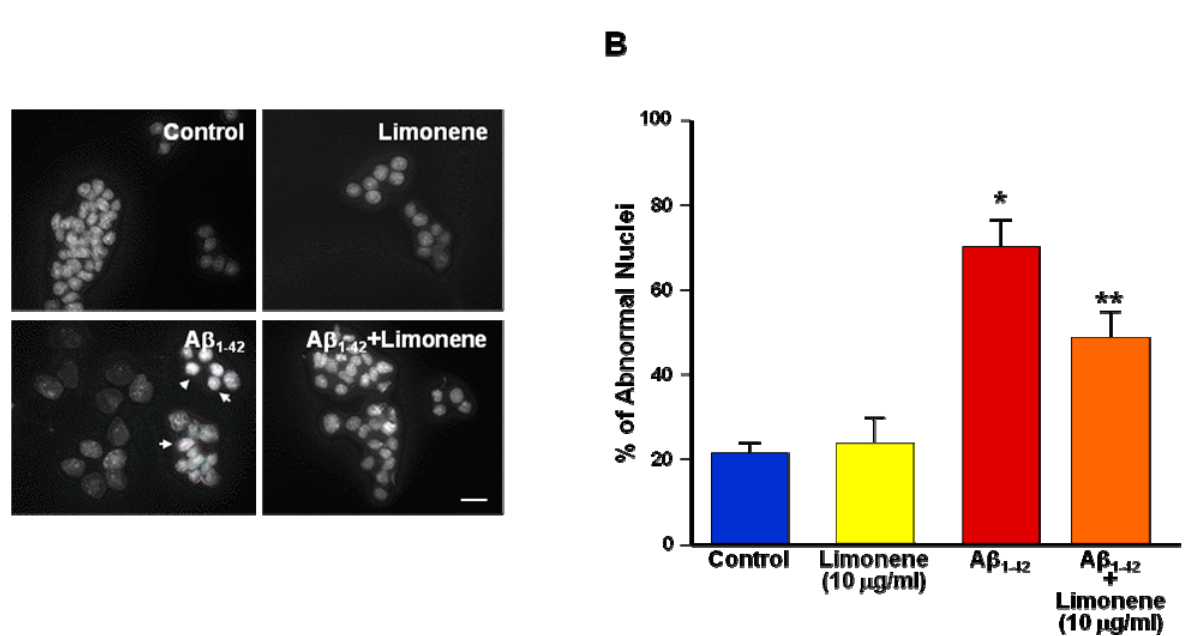
Figure 2. Effects of limonene on nuclear morphology in primary cortical neurons exposed to A β 1-42 oligomers. ( A ) Representative images of Hoechst-33258 nuclear morphological abnormalities in primary cortical neurons under control conditions, in neurons treated with limonene (10 µg/mL/24 h), and treated with A β 1-42 oligomers (5 µM/24 h; see white arrows) in the absence and in presence of limonene (10 µg/mL, 30 min pre-treatment) Scale bar: 20 µm. ( B ) Quantification of nuclear morphology with Hoechst-33258 in A. Data are shown as percentage of abnormal nuclei (relative to total nuclei) and values are expressed as mean ± SEM of four independent experimental sessions in which at least 10 microscopic fields were analyzed (* p < 0.05 vs control; ** p < 0.05 vs A β 1-42 ).